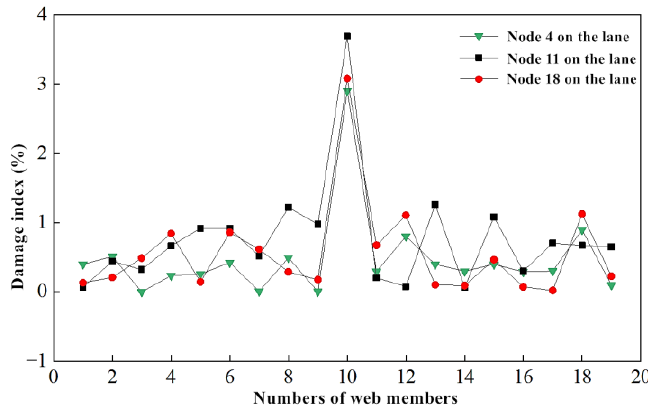
Figure 9. Damage detection results under 4% damage condition.